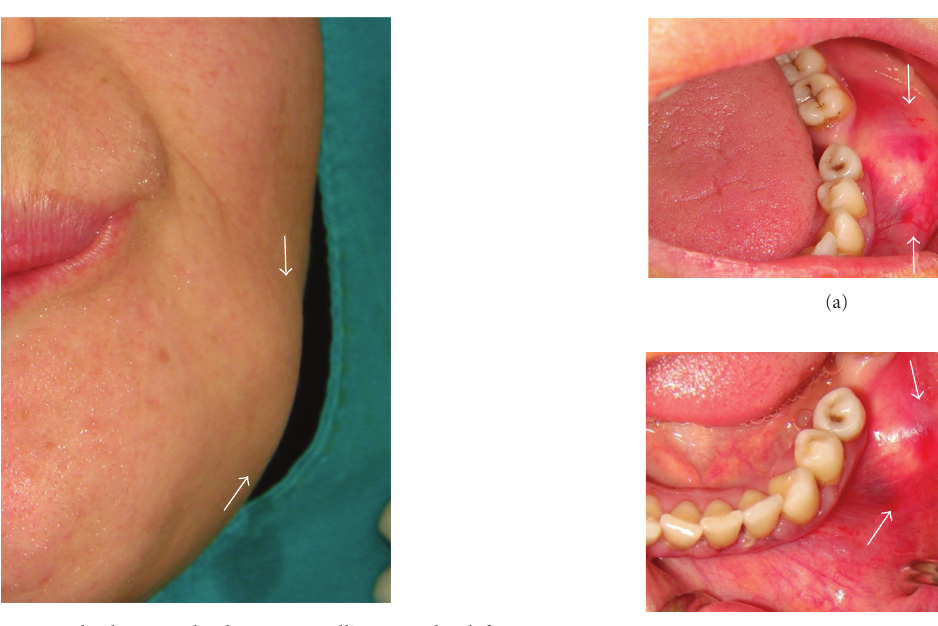
Figure 1: Extraoral photograph shows a swelling on the left posterior body of the mandible.